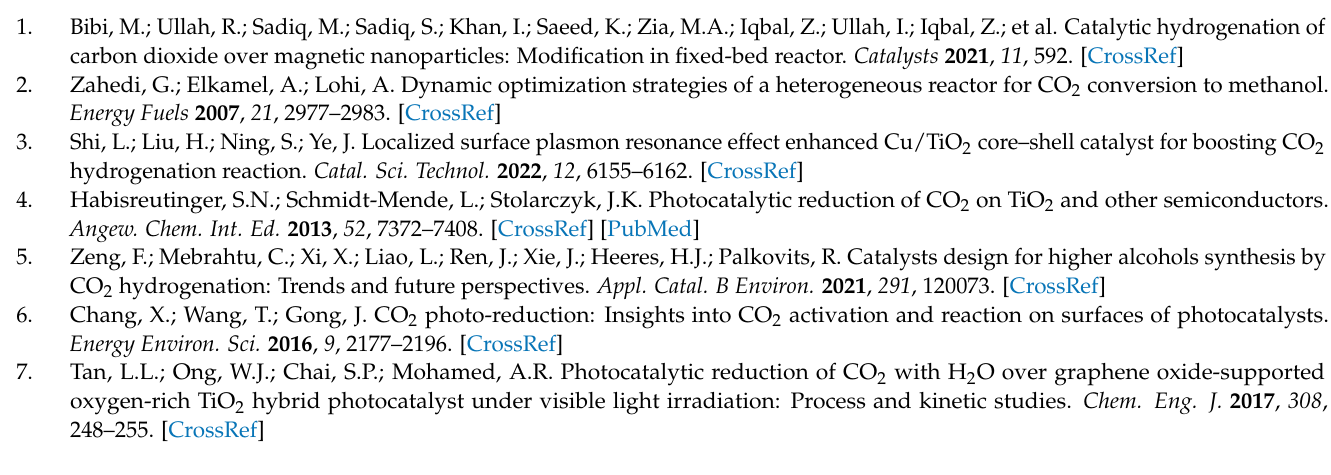
Figure S4: N 2 sorption isotherms of P25 and pBT(2)/P25; Figure S5: XPS spectra of pBT(2)/P25; Figure S6: HR-XPS spectra of Ti 2p, O 1s in pure P25 and pBT(2)/P25, Bi 4f and Te 3d in pure pBT and pBT(2)/P25; Figure S7: GC spectra of CO, CH 4 , H 2, and O 2 in CO 2 photoreduction; Figure S8: CO evolution rates over pBT(2)/P25 and pBT(2)/Al 2 O 3 ; Figure S9: In situ monitoring of the photother- mal temperatures over pBT(2)/P25 and pBT(2)/Al 2 O 3 ; Figure S10: Light spectra of the Xe lamp with or without a Y44 filter; Figure S11: In situ monitoring of the photothermal temperatures over pBT(2)/P25 under Xe lamp irradiation with and without a Y44 filter; Figure S12: In situ monitoring of the photothermal temperatures over P25 and pBT(2)/P25 under photothermal and cooling conditions; Table S1:Temperatures over P25 and pBT(x)/P25 under photothermal and cooling conditions; Figure S13: CO evolution rates over pBT(x)/P25 under photothermal and cooling conditions; Figure S14: Three cycles of CO 2 photoreduction over pBT(2)/P25; Figure S15: XRD patterns of pBT(2)/P25 before and after reaction; Figure S16: HR-XPS spectra of Ti 2p, O 1s, Bi 4f, and Te 3d in pBT(2)/P25 before and after reaction; Figure S17: In situ monitoring of photoanodes surface tempera- tures; Table S2: Surface temperatures of P25 and pBT(x)/P25 photoanodes; Figure S18: CO evolution rates over P25 and pBT(x)/P25 under Xe and UV lamps irradiation; Figure S19: In situ monitoring of the photothermal temperatures over pBT(2)/P25 under Xe and UV lamps; Table S3: Comparison of CO 2 photoreduction performance over TiO 2 -based photocatalysts. References [64–71] are cited in the supplementary